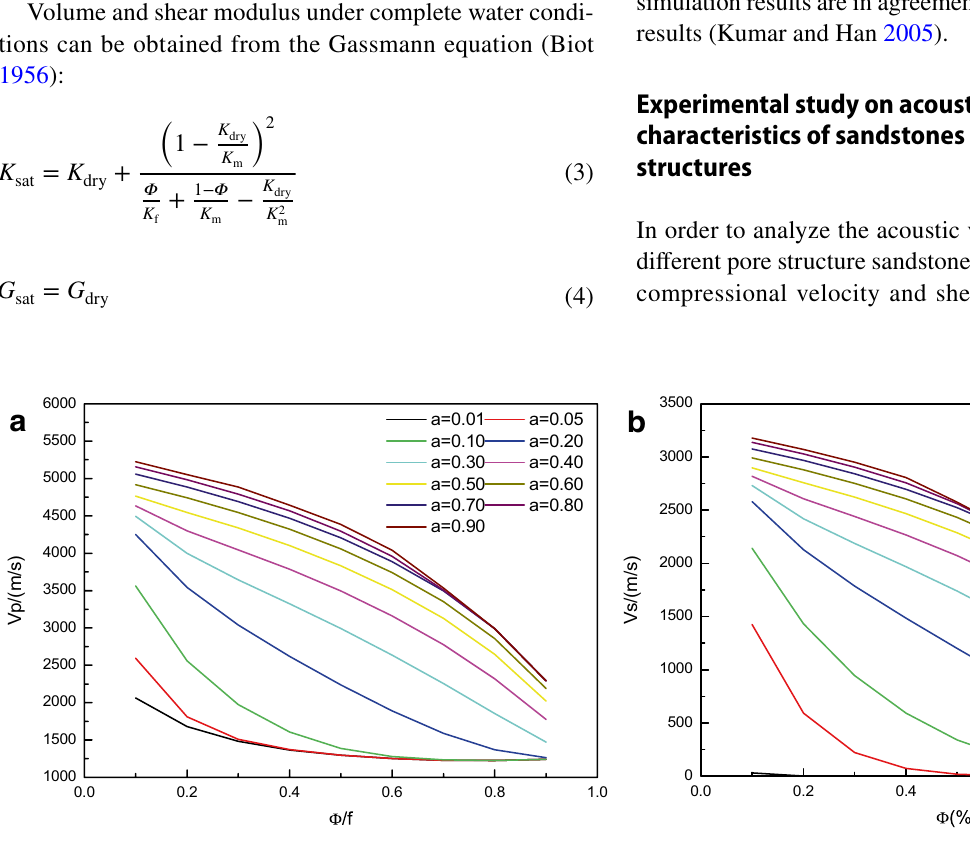
Φ ; b theoretical relationship between V p and